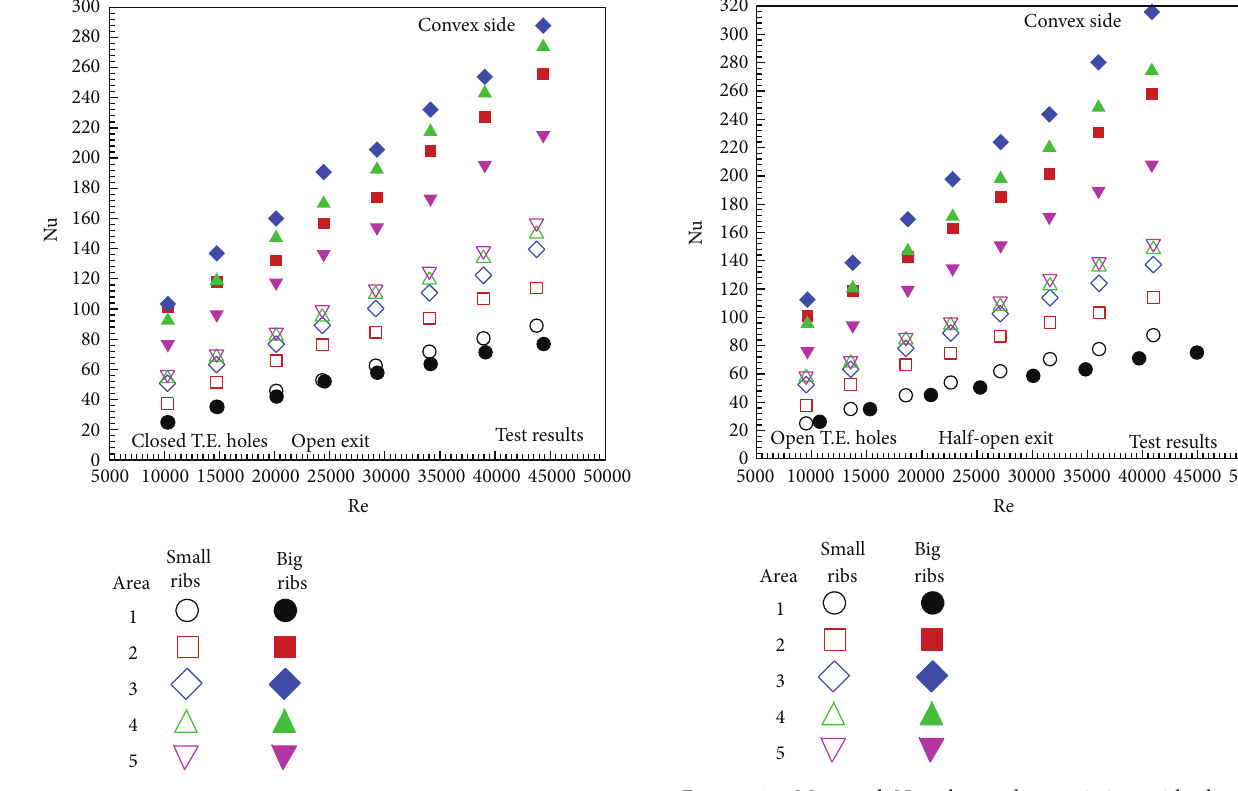
Figure 16: Measured Nusselt number variation with Reynolds number on all areas on the convex wall for the two rib geometries, closed trailing-edge holes, and open channel exit.